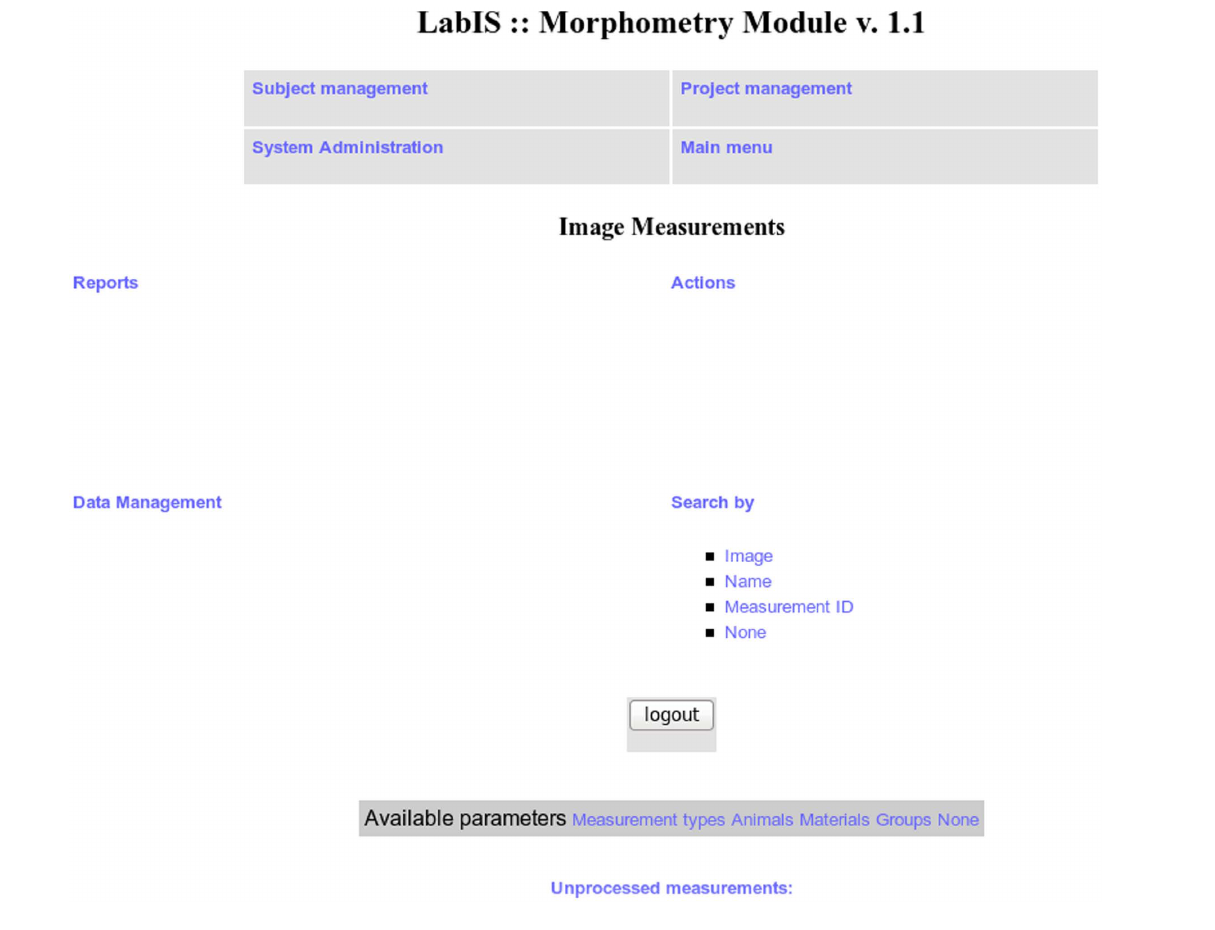
FIGUREA3 |The Image measurements and morphometry